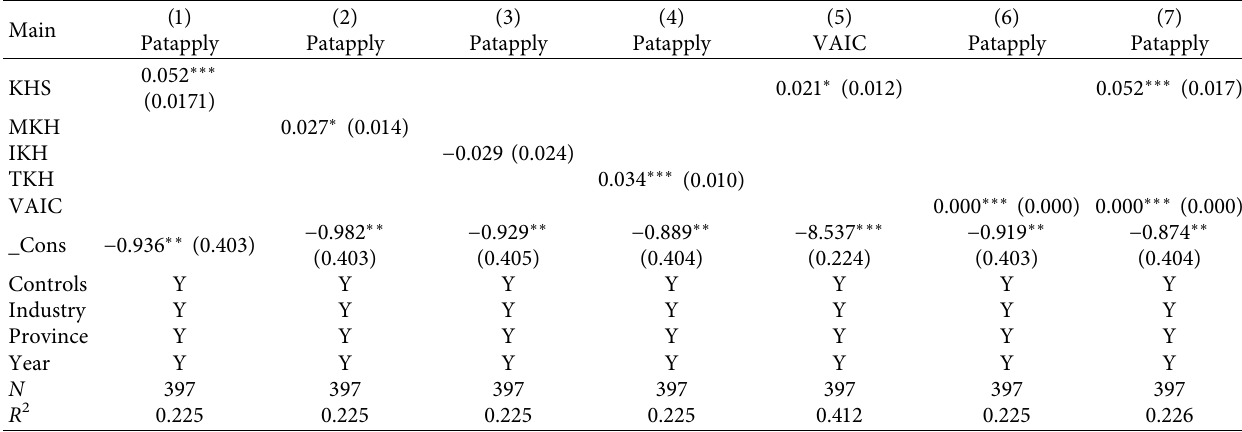
Table 5: Relationship between KHS, IC, and IP of entrepreneurial firms.